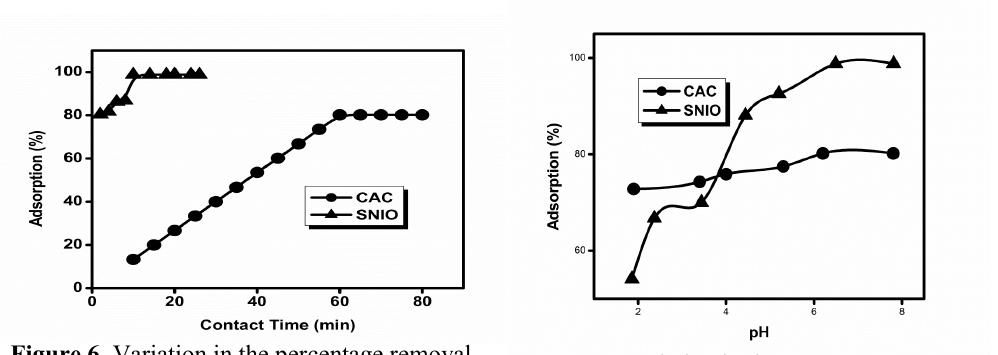
Figure 7. Variation in the percentage removal of the Ni(II) ion by CAC and SNIO with change in pH (Ni(II) ion optimum concentration: 29.7 ppm (CAC), 50ppm (SNIO) ; optimum dose rate: 13.3 g/L CAC , 2.574g/L SNIO ; optimum contact time:60min (CAC), 10 min